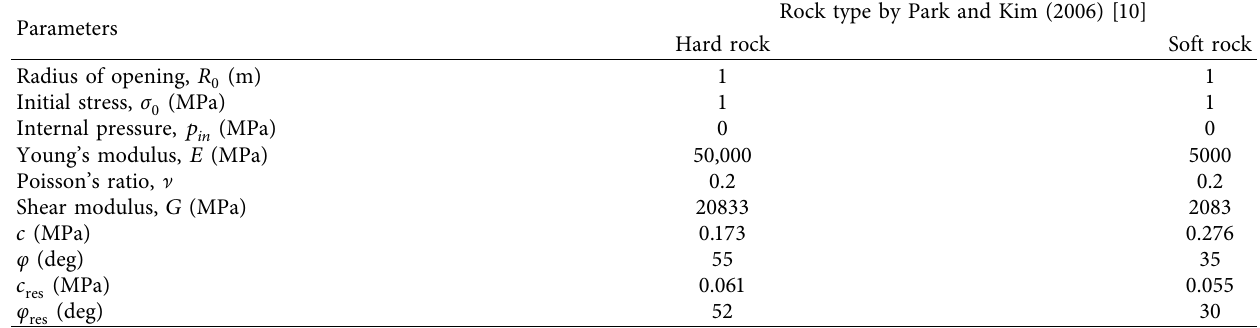
Table 2: Geometrical and physical parameters of circular opening.